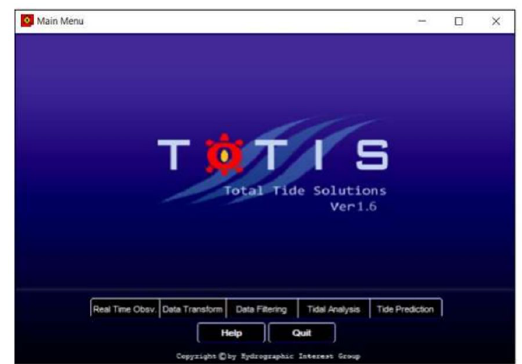
Figure 4. The main interface of tidal prediction in TOTIS software